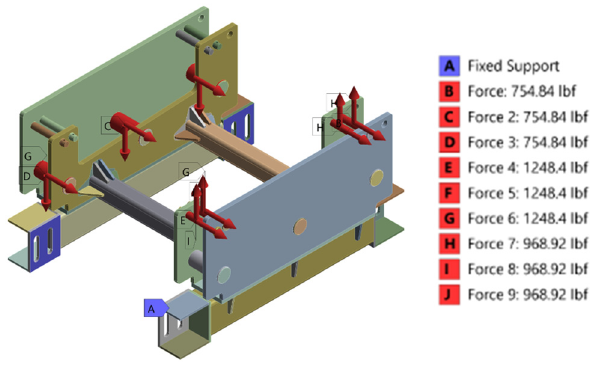
Figure 9: Load and boundary conditions for load case 3.